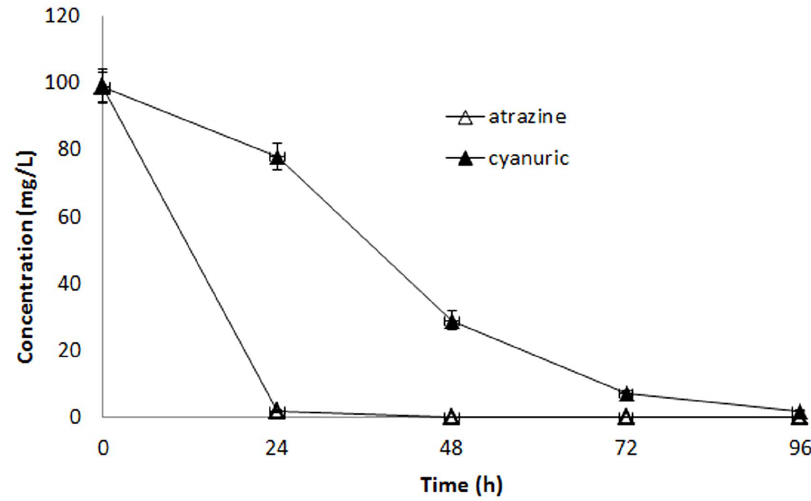
Figure 3. Degradation of atrazine and cyanuric acid by HB-6. g , atrazine as the initial compound in the medium; m , cyanuric acid as the initial compound in the medium. Error bars represent the standard deviation of three